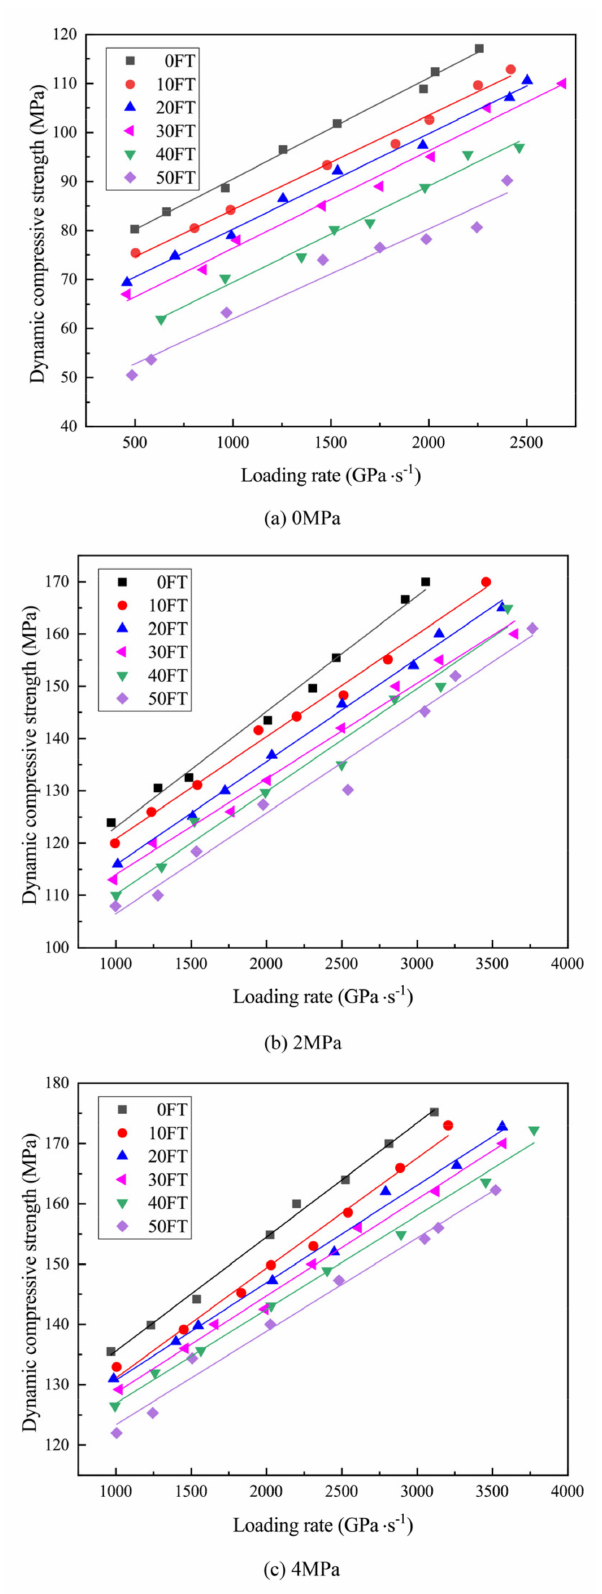
Figure 10. Dynamic compressive strength of FT cycling-treated specimens subjected to different hydrostatic pressures: ( a ) 0 MPa; ( b ) 2 MPa; and ( c ) 4